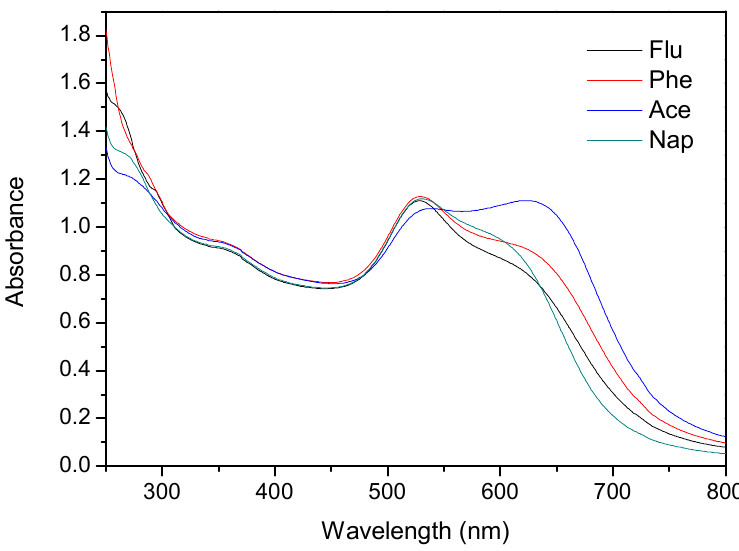
Figure 10. UV-vis absorbance of functionalized AuNPs in the presence of Flu, Phe, Ace, and Figure 10. UV ‒ vis absorbance of functionalized AuNPs in the presence of Flu, Phe, Ace, and Nap.